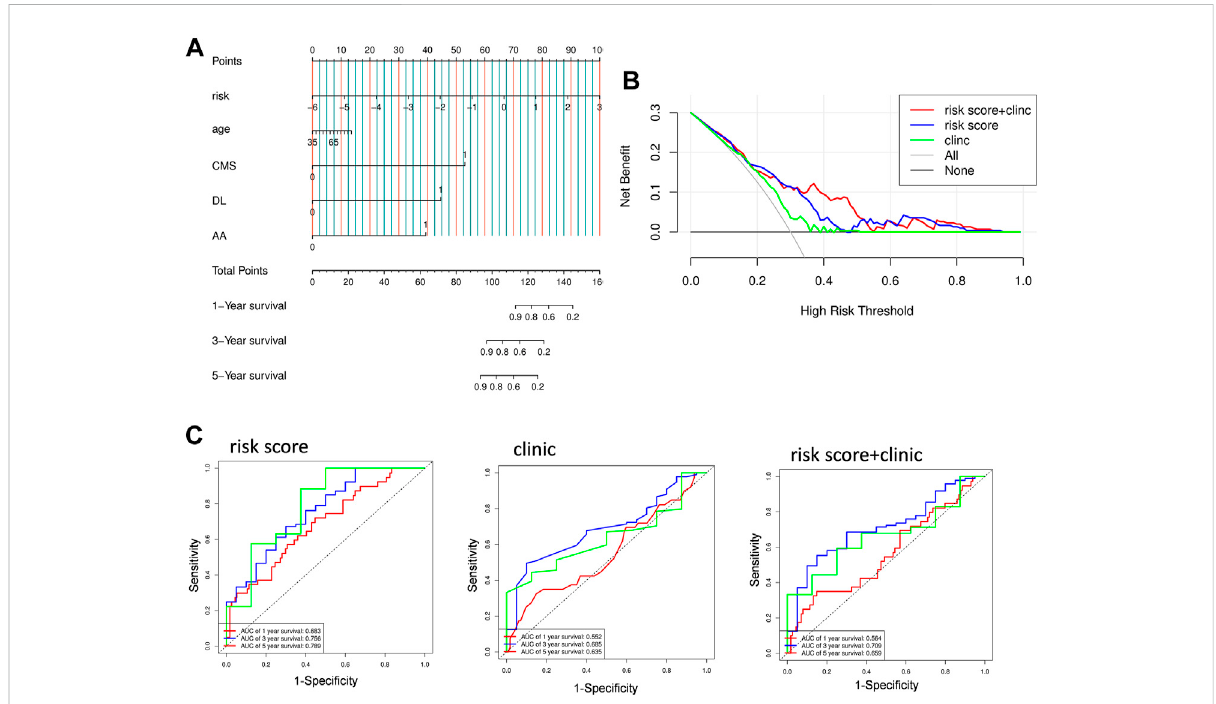
FIGURE 6 Validation prognostic ef fi ciency ofPRGssignature. (A) Nomogram predicted 1- ,3-, and 5-years OS based on prognosticmodel combined with clinical characteristic in the TCGA cohort. CMS: Cystic, Mucinous and Serous Neoplasms; DL: Ductal and Lobular Neoplasms; AA: Adenomas and Adenocarcinomas. (B) The decision curveofthe risk score,clinicalcharacteristic and their combination. (C) time-dependent ROC curves for therisk score, clinical characteristic, or their